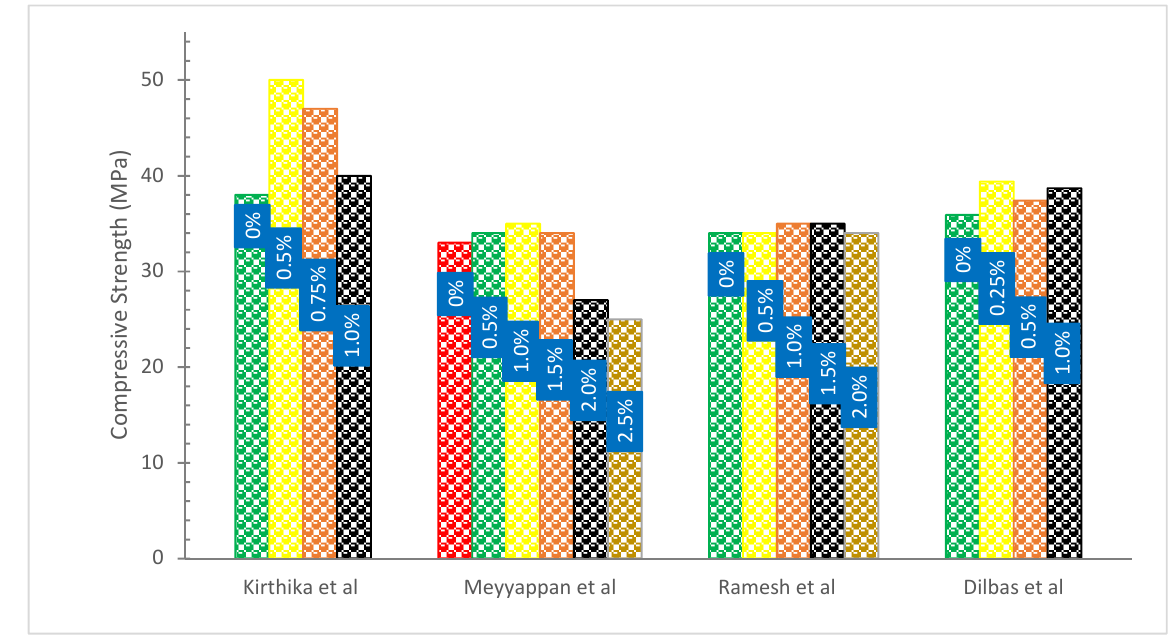
Figure 6. Compressive Strength: Data Source [32,50,63,67]. According to research, adding BFs at 0.5 percent resulted in a 3.9 percent decrease in CS after 28 days [40]. There was no discernible increase in the CS of basalt FRC and polypropylene fiber in this investigation. The CS of the specimens reinforced with polypropylene fiber with a volume fraction of 0.05%, 0.1%, and 3% increases by 2.41 percent, 6.13 percent, and 4.32 percent, respectively, as compared to plain concrete. The BFs exhibited a better CS gain at the same volume fraction when compared to polypropylene fiber. The CS enhancement of reinforced concrete with BFs (12 mm length) varies from 3.74 percent to 6.49 percent when adding v with volume fractions of 0.05, 0.1, 3.0, and 0.5 percent [36]. An adequate quantity of BFs may be included to increase the CS at various ages, according to research [51]. The CS of BFs (0.5%) is the greatest, being 9.87 percent and 17.13 percent greater at 28 and 90 days, respectively, than that of the reference concrete (BFs 0%). The CS does, however, decline as fiber content rises, and the strength decline becomes more pronounced the higher the fiber concentration. The lowest CS is shown by BFs (0.20 percent), which is 8.08 and 5.15 percent less than that of the control concrete after 28 and 90 days, respectively. The three-dimensional randomly dispersed BFs bundles, which are tightly bonded when the fiber content is suitable, limit the transverse deformation under compression [51]. According to the fiber spacing theory, a portion of the load is also carried by the fiber when concrete is loaded because stress expands along the aggregate interface before moving to the fiber position. When the fiber is removed, friction between the fiber and the concrete interface uses up some energy, delaying the concrete’s eventual deterioration. As a result, the CS of the concrete increases. The total fiber surface area rises significantly when the fiber proportion is at a higher ratio. As a result, more cement pastes are needed to coat the fibers, which affects how well the cement pastes and aggregates bond together. In addition, a high fiber content directly reduces the matrix’s average fiber spacing resulting in less strength. Table 2 shows the summary of strength properties of concrete with BF addition.